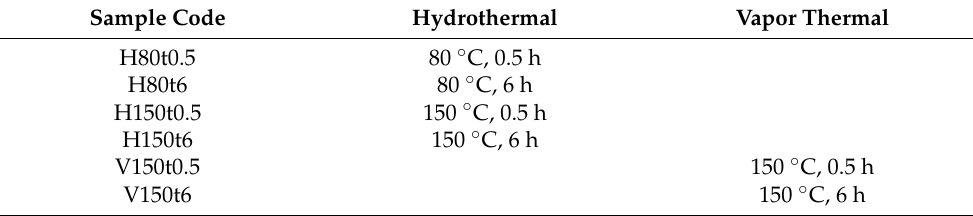
Table 1. Sample code and experimental conditions under hydrothermal or vapor thermal